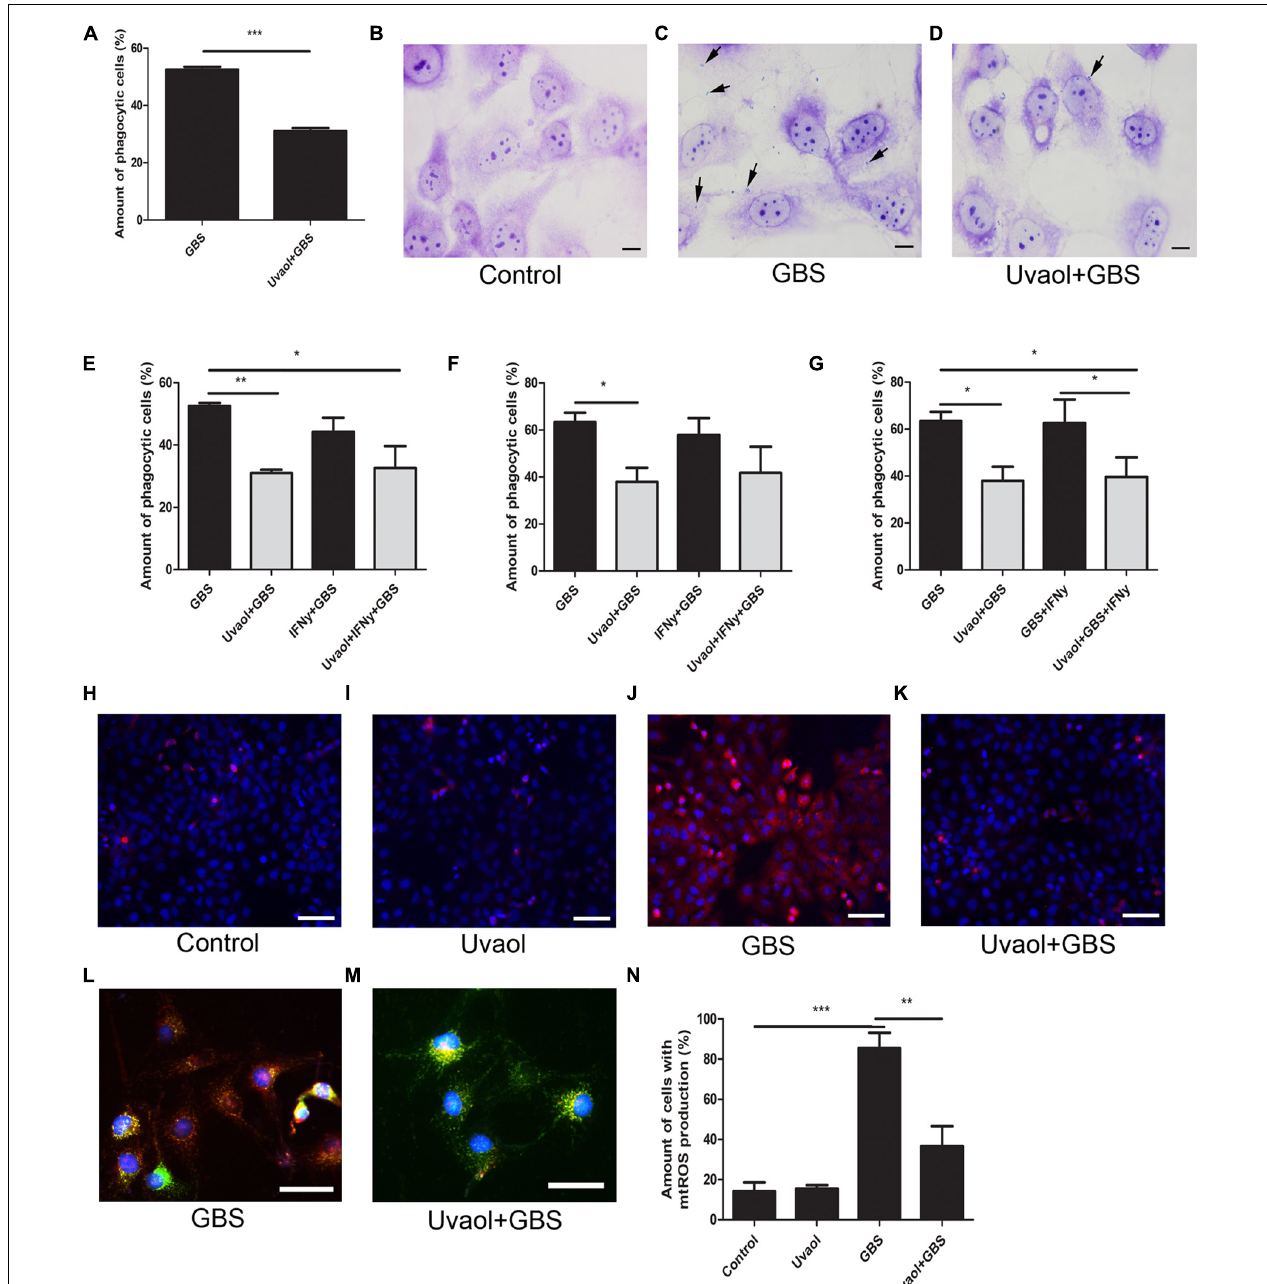
FIGURE 4 | Uvaol reduces trophoblast cells phagocytosis and mtROS production. (A) Phagocytosis quantification after 2 h of GBS inoculation. HTR8SV/neo cells were treated with 10- µ M uvaol for 1 h and incubated with GBS at 10 6 CFU for further 2 h. A bar graph represents mean values ± S.E.M.; n = 4 in triplicate. ***; p = 0.004. Paired t-test . (B–D) Cells were stained by Giemsa staining for phagocytosis assessment, where: (B) control, (C) GBS, and (D) uvaol + GBS group. Black arrows show bacteria in trophoblast cells. 1,000 × magnification. Scale bars represent 20 µ m. (E) Phagocytosis quantification after 2 h of GBS inoculation. HTR8SV/neo cells were treated for 24 h with 100 UI/ml IFN- γ and/or 1 h with 10- µ M uvaol before GBS at 10 6 CFU incubation for further 2 h. (F) Phagocytosis quantification after 24 h of GBS inoculation. HTR8SV/neo cells were treated for 24 h with 100-UI/ml IFN- γ and/or 1 h with 10- µ M uvaol before GBS at 10 6 CFU incubation for further 2 h. (G) Phagocytosis quantification after 24 h of GBS inoculation. HTR8SV/neo cells were treated for 1 h with 10- µ M uvaol before GBS at 10 6 CFU for 2 h, and 100 UI/ml IFN- γ for further 22 h. A bar graph represents mean values ± S.E.M.; n = 3 in triplicate. *; p < 0.05, **; p < 0.01. One-way ANOVA with Tukey post hoc test. (H–K) Cells were stained with MitoSOX red and nuclei with DAP-I, where: (H) control, (I) uvaol, (J) GBS, and (K) uvaol + GBS group. 200 × magnification. Scale bars represent 200 µ m. (L,M) Cells were stained with MitoTRACKER green, MitoSOX red, and nuclei with DAP-I were (L) GBS and (M) uvaol + GBS group. 1,000 × magnification. Scale bars represent 100 µ m. (N) mtROS quantification. A bar graph represents mean values ± S.E.M.; n = 3 in triplicate. **; p < 0.01, ***; p < 0.001. One-way ANOVA with Tukey post hoc test.